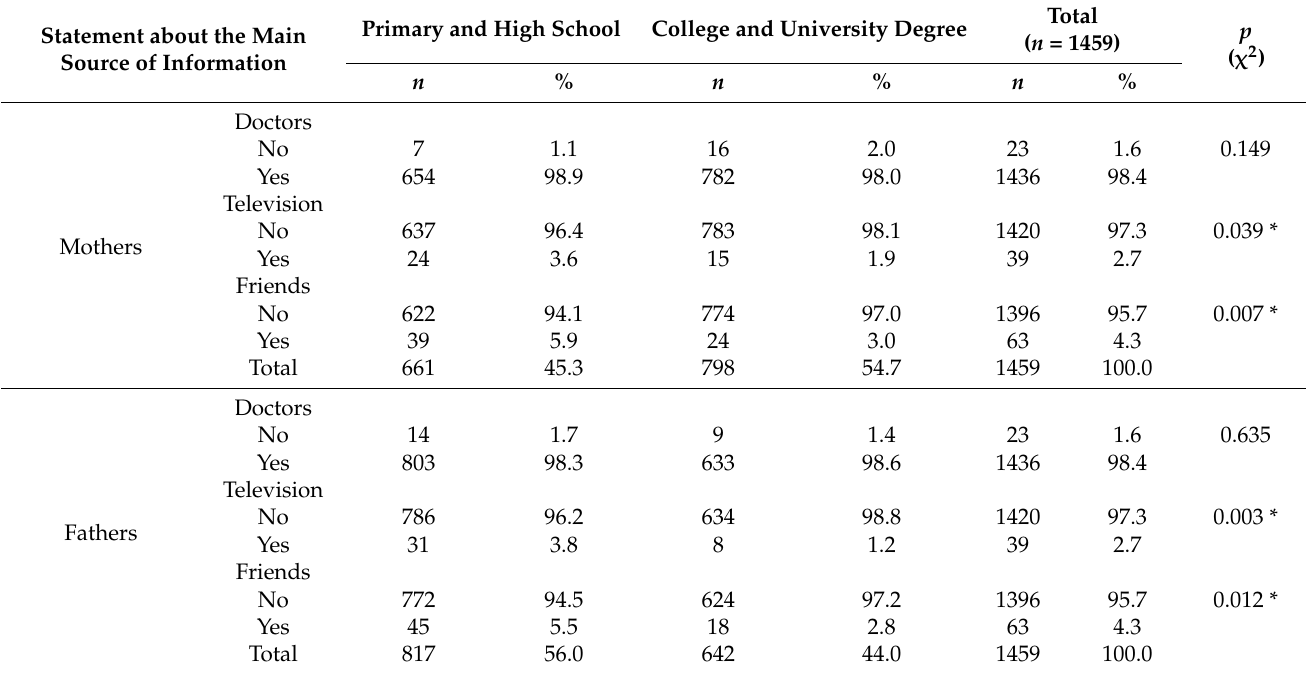
Table 4. Main sources of information when deciding on the use of antibiotics with regard to level of education of